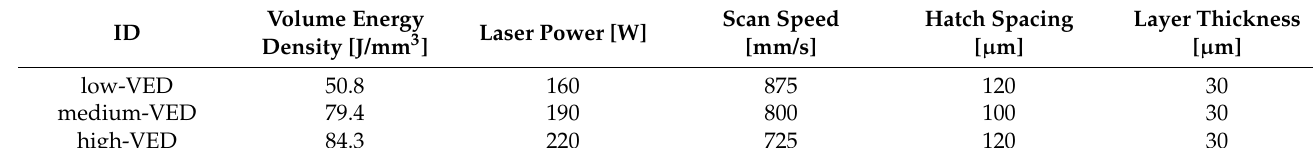
Table 2. Fabrication parameters for AISI 316L specimens.